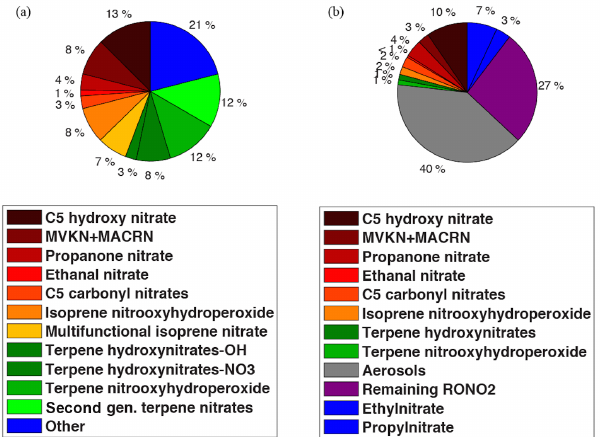
Figure 5. The composition of the (a) simulated organic nitrates by WRF-Chem using RACM2_Berkeley2 and (b) observed organic ni- trates during SOAS at